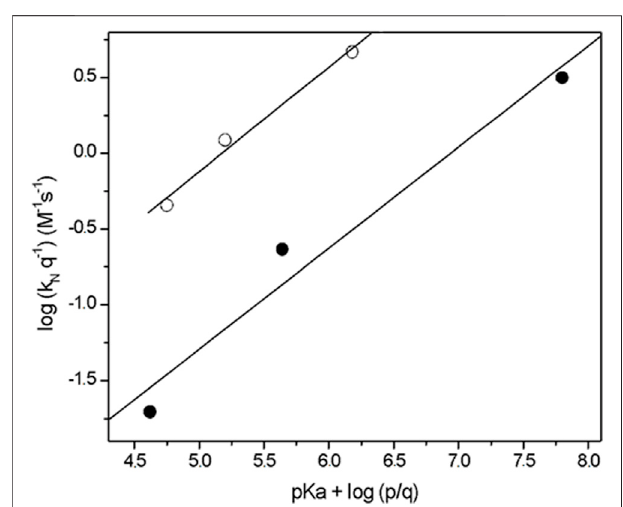
FIGURE 1 | Brønsted -type plots (statistically corrected) obtained for the reactionsof2-choro-5-nitropyrimidinewithalphanucleophileseriesinaqueous solution,at25.0 ° Candionicstrengthof0.2 MinKCl.Inincreasingorderof pK a : empty circles correspond to N,O -dimethyl hydroxylamine, N , N -dimethyl hydroxylamine and N-methyl hydroxylamine compounds; and full circles correspond to: methoxylamine, hydroxylamine and hydrazine